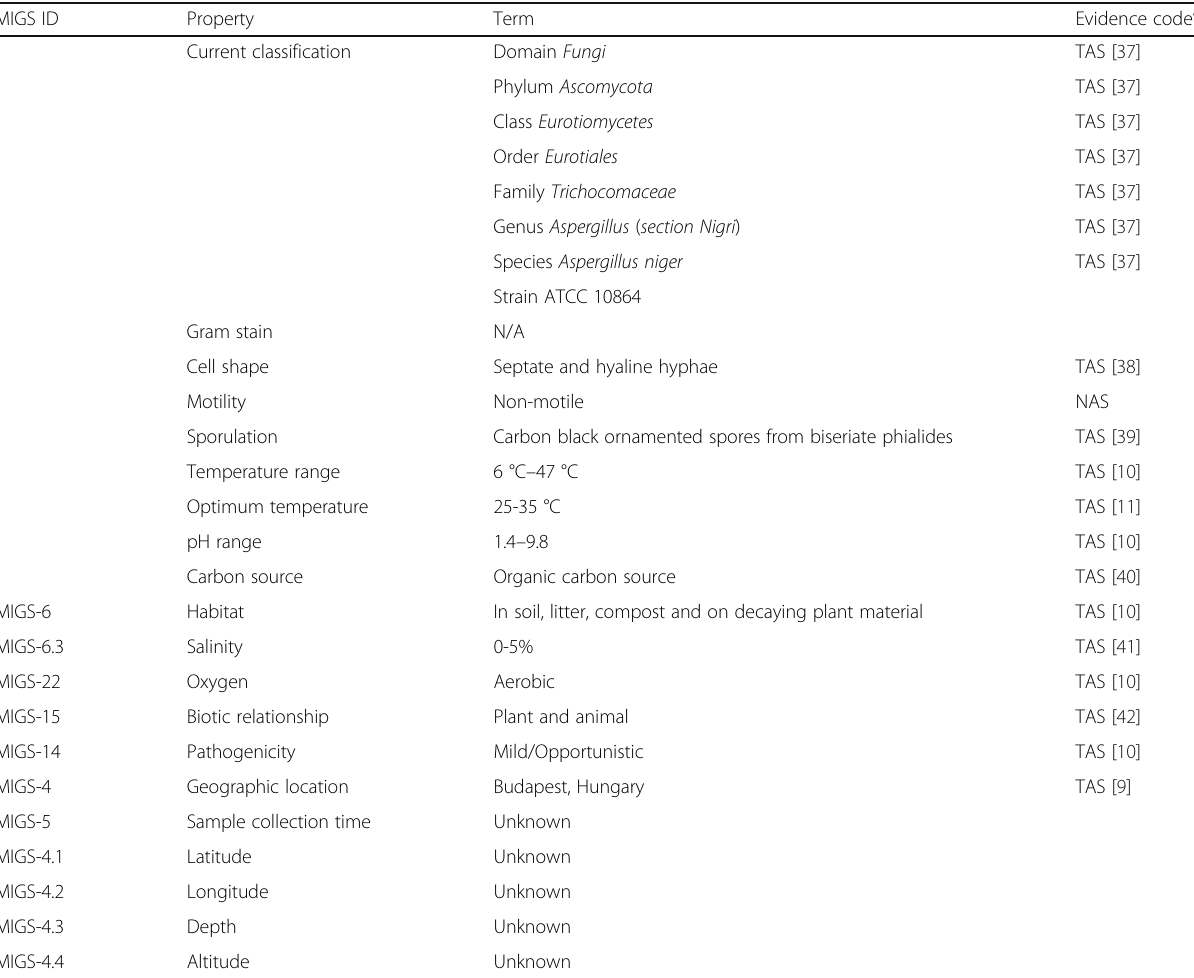
Table 1 Classification and general features of Aspergillus niger strain ATCC 10864 MIGS